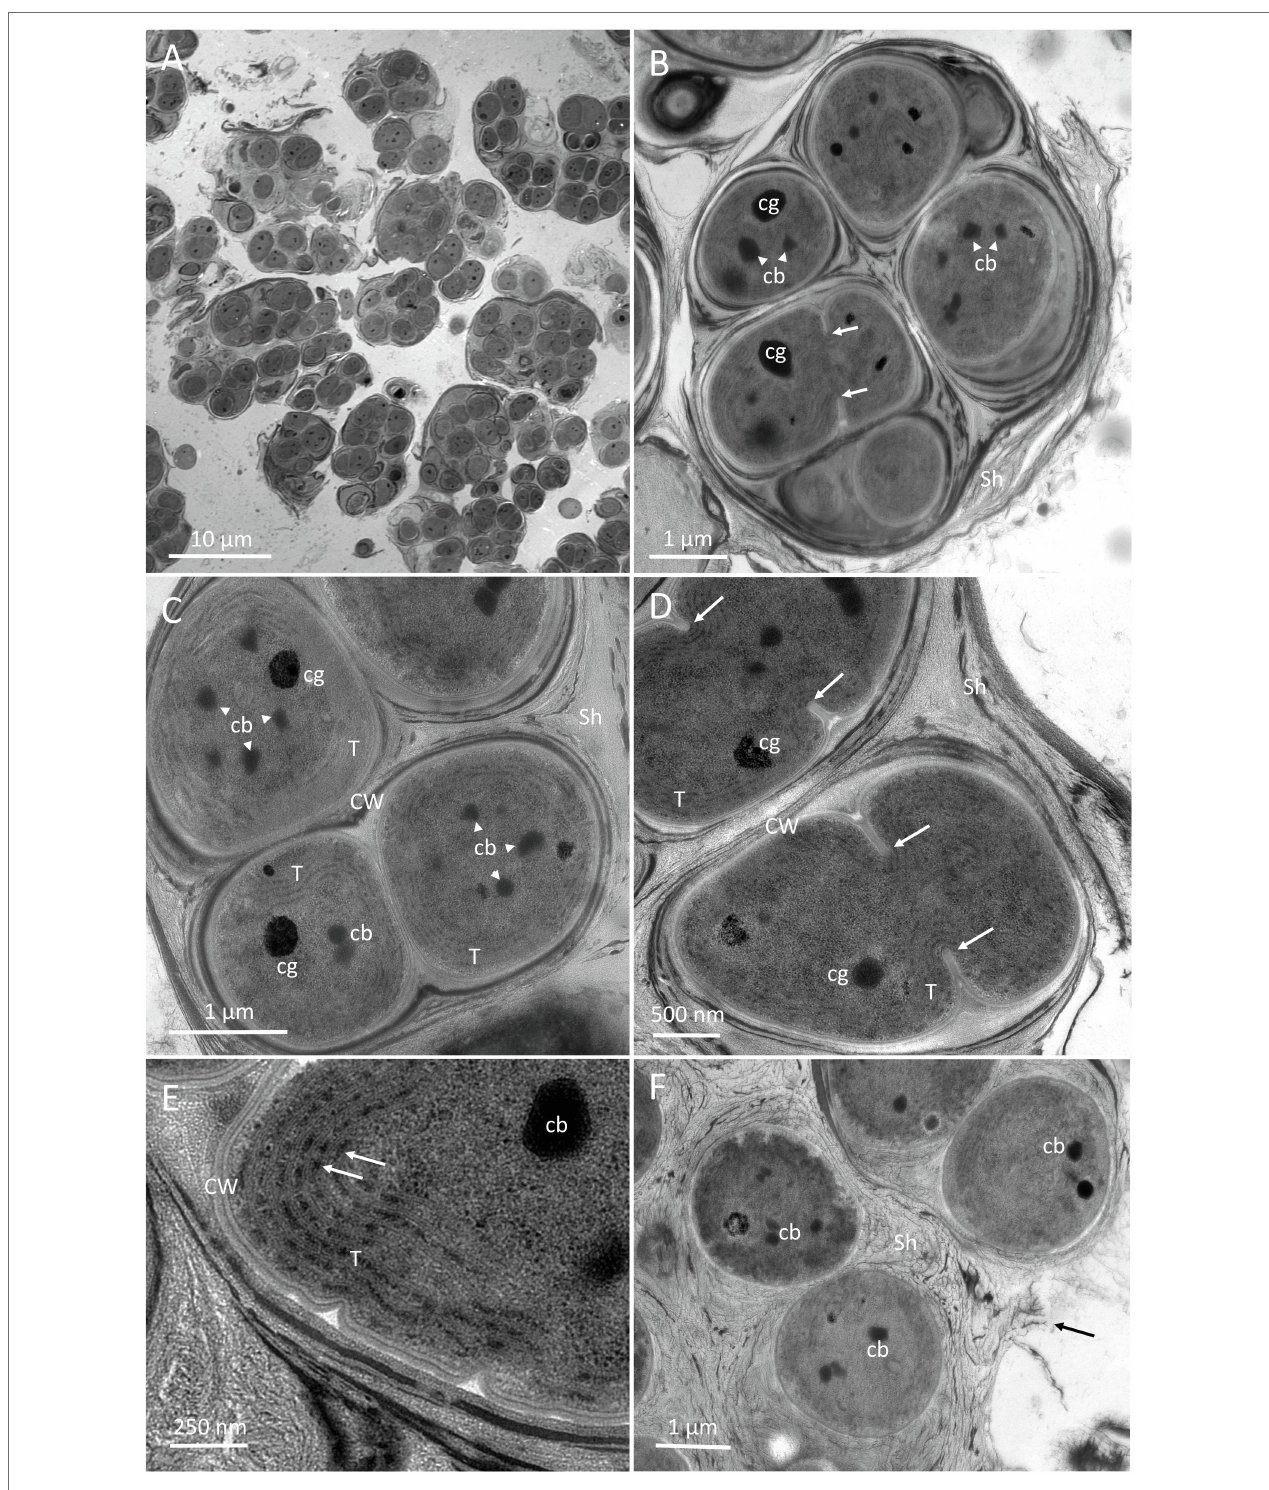
FIGURE 8 | TEM micrographs of G. diffluens sp. nov. strain PJ S16. (A) depicts the diffluent shape of cell colonies. (B) shows a colony of cells, with one of them (arrows), along carboxysomes and lipid bodies in the central cytoplasm. (C) Cell colony with one freshly divided cell still in mother cell wall, thylakoids parietal, carboxysomes, and electron dense bodies. (D) depicts two dividing cells (arrows pointing to invaginations forming the septum). (E) Details of the cortical area, with thylakoid membranes and phycobilisomes (arrows). (F) shows cells embedded in a loose extracellular polymeric substances (EPS), which appears to disintegrate. Abbreviations: cb, carboxysome; CW, cell wall; Sh, sheath made of extracellular EPS; and cg, cyanophycin